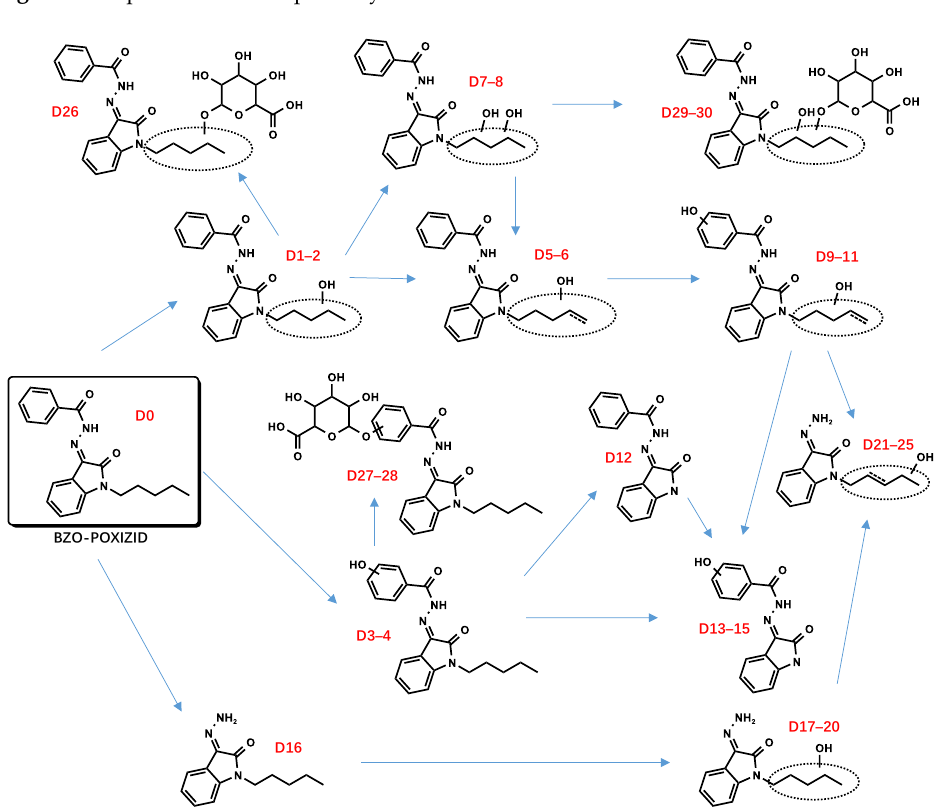
Figure 6. Proposed metabolic pathway of BZO-POXIZID.